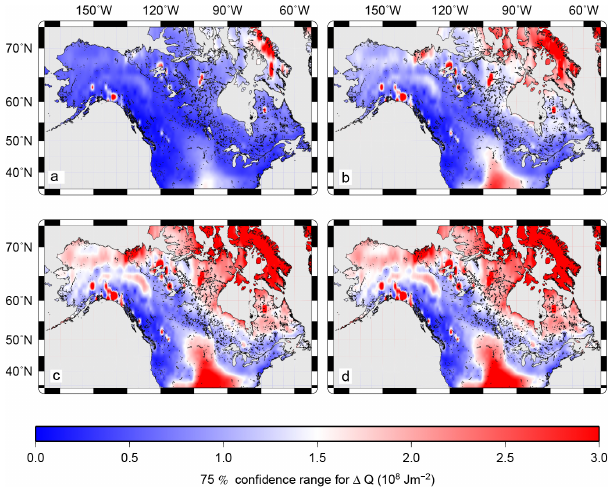
Figure 9. Spatial distribution of the 75% uncertainties in subsur- face thermal energy storage for the corresponding panels in Fig.